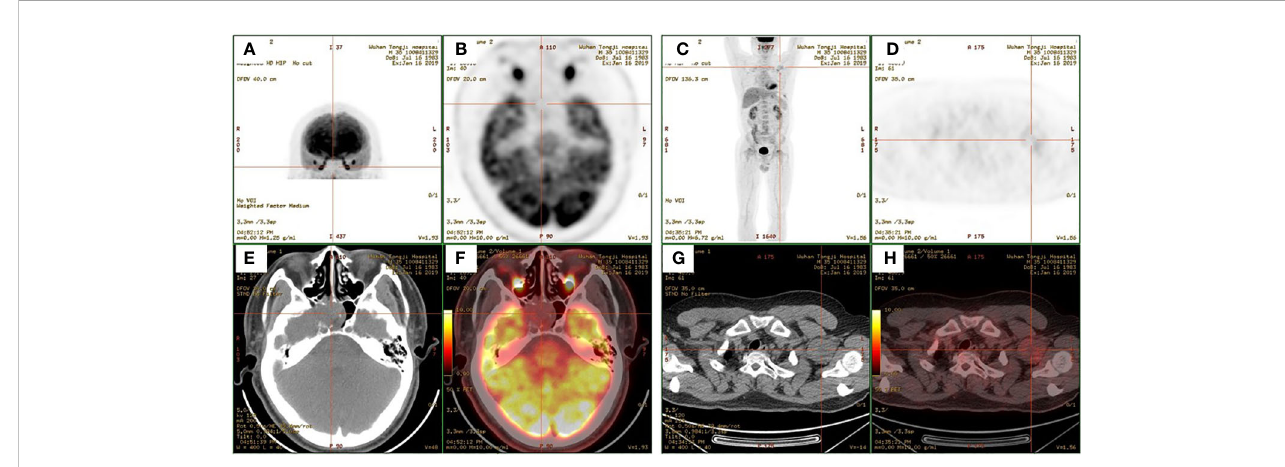
FIGURE 3 (A, C) Maximum-intensity projection images of the patient. (B, D) Axial views of the sphenoid sinus tumor (B) and the axillary tumor (D) in 2-deoxy-2- [ fl uorine-18] fl uoro- D -glucose positron emission tomography ( 18 F-FDG PET). (E, G) Axial views of the sphenoid sinus tumor (E) and the axillary tumor (G) in CT. (F, H) Fusion